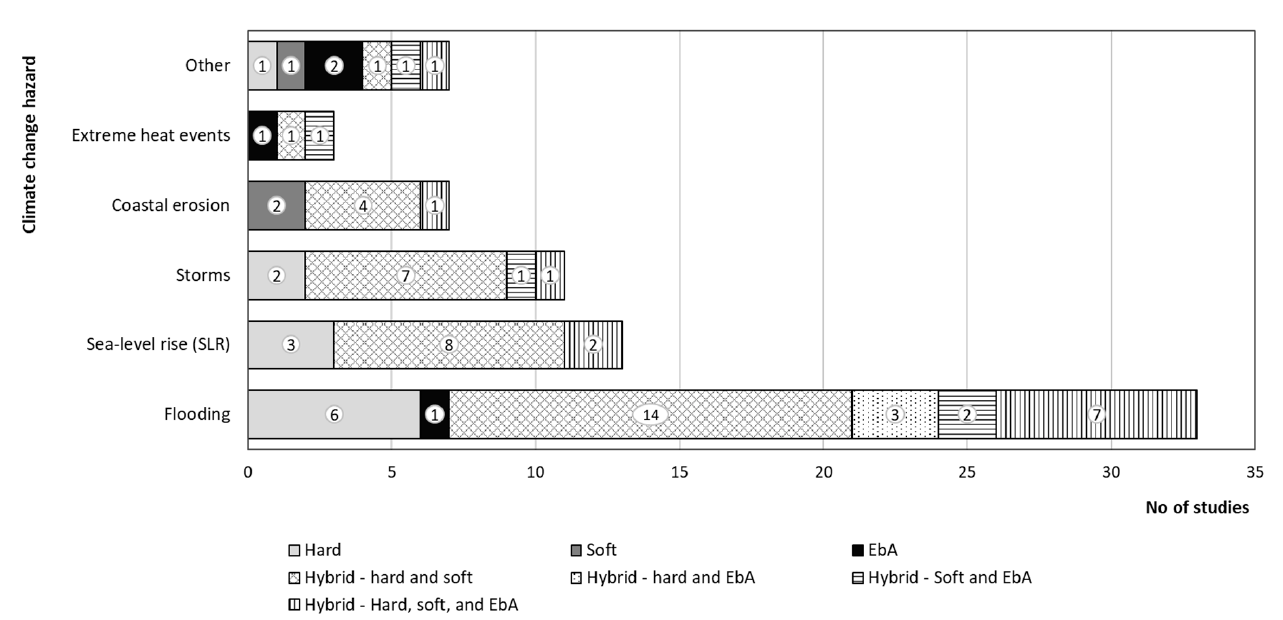
Figure 3. Adaptation strategies addressing climate-change hazards (number of studies).